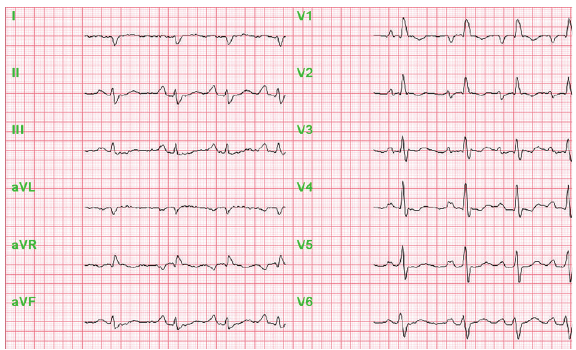
Figure 3: ECG in a patient with severe pulmonary